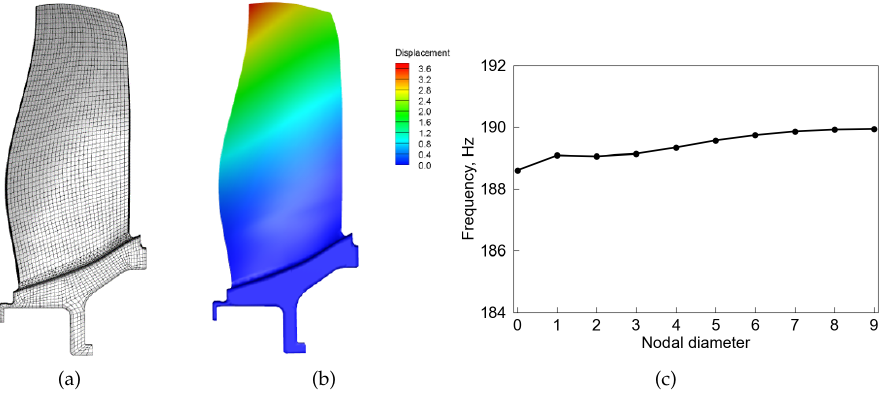
Figure 9. FEA mode analysis. ( a ) FEA mesh. ( b ) 1F mode shape. ( c ) Natural frequencies of the 1F mode versus nodal